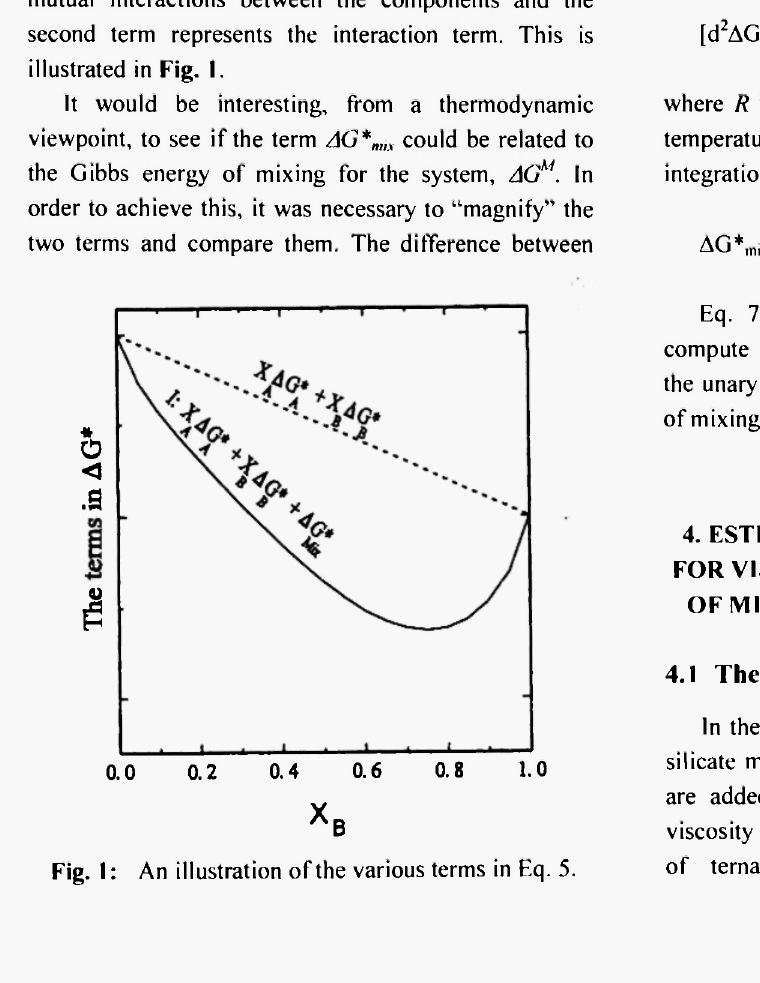
Fig. 1: An illustration of the various terms in Eq.